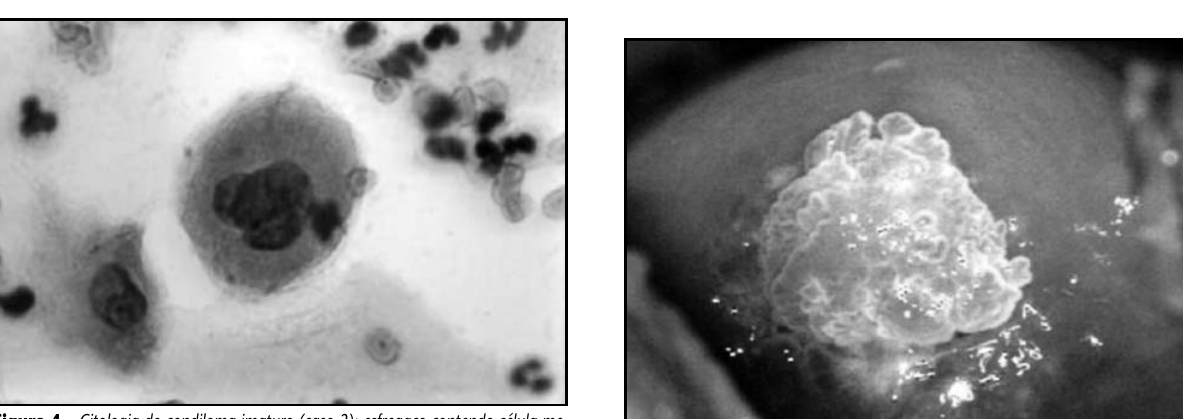
Figura 4 – Citologia do condiloma imaturo (caso 2): esfregaço contendo célula me- taplásica atípica, com núcleos múltiplos hipercromáticos, de carioteca discretamente irregular (coloração de Papanicolaou, aumento de